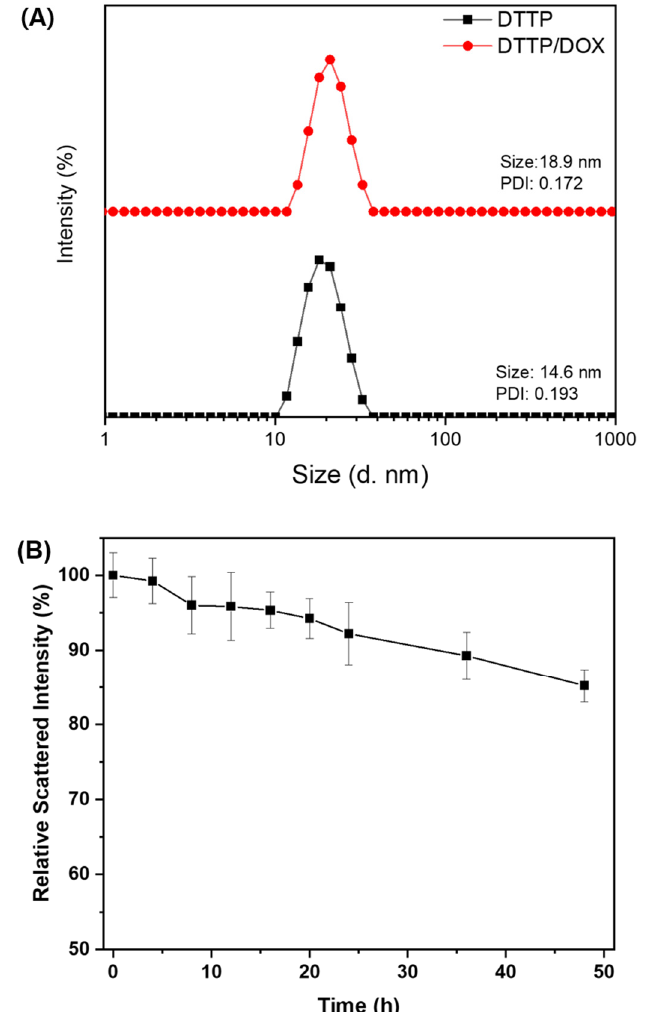
Figure 2. Particle size distributions of blank DTTP and DOX-loaded DTTP micelles ( A ). Scattered light intensity of DTTP micelles after addition of a 5-fold weight excess of SDS (Data are means ± S.D. of three independent experiments) ( B ).